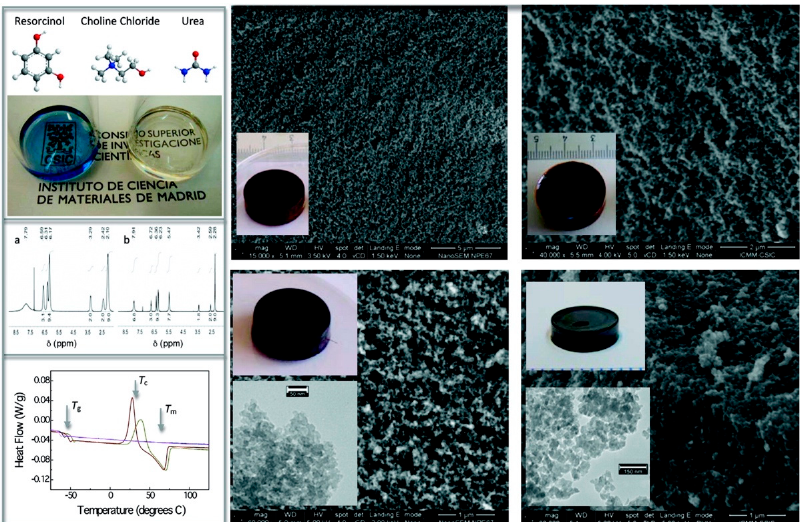
Figure 6. Preparation of porous carbon monoliths via resorcinol-formaldehyde polycondensation from polymerizable eutectics. Left panel: preparation and accompanying characterization of resorcinol:ChCl and resorcinol:ChCl:urea polymerizable eutectics; the blue sample contains urea. Right panel: SEM images and digital photographs of polymer resins ( top ) and monolithic carbons ( bottom ) prepared from these eutectics. Also provided are TEM insets of the carbon monoliths. Adapted with permission from [86], Copyright 2010 American Chemical Society.